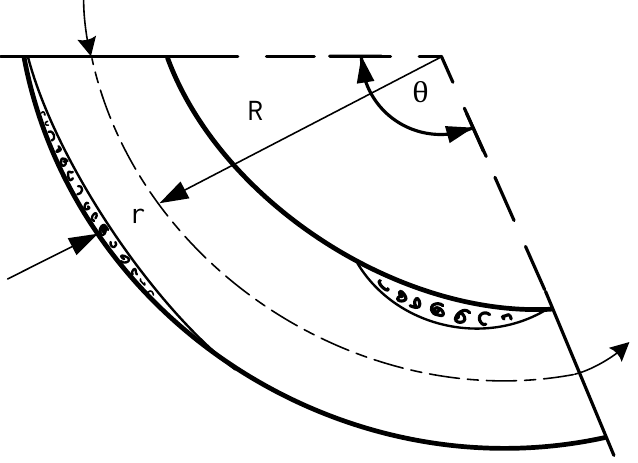
Figure 1. Diagram of local loss of bent pipes